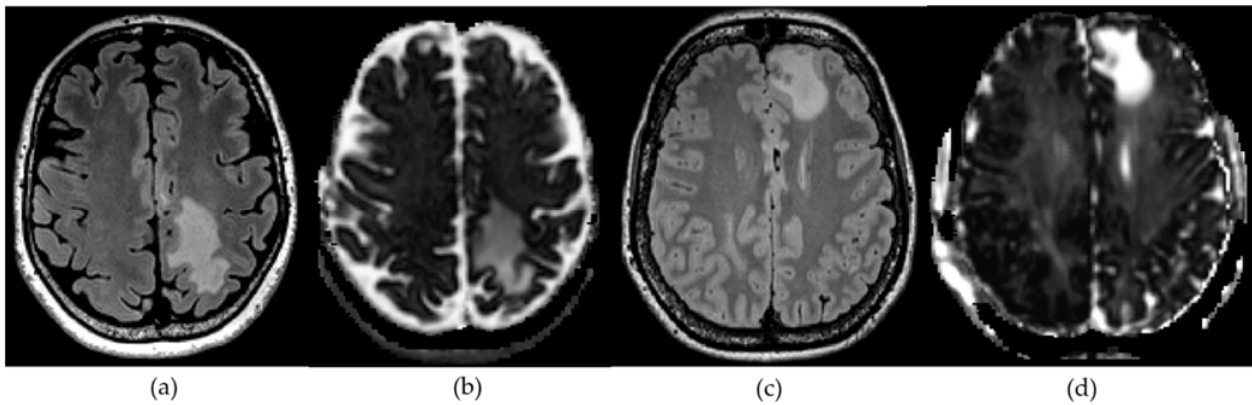
Table 1. Patient characteristics and ROI (perilesional T2 hyperintense area) ‐ derived diffusion met ‐ rics.